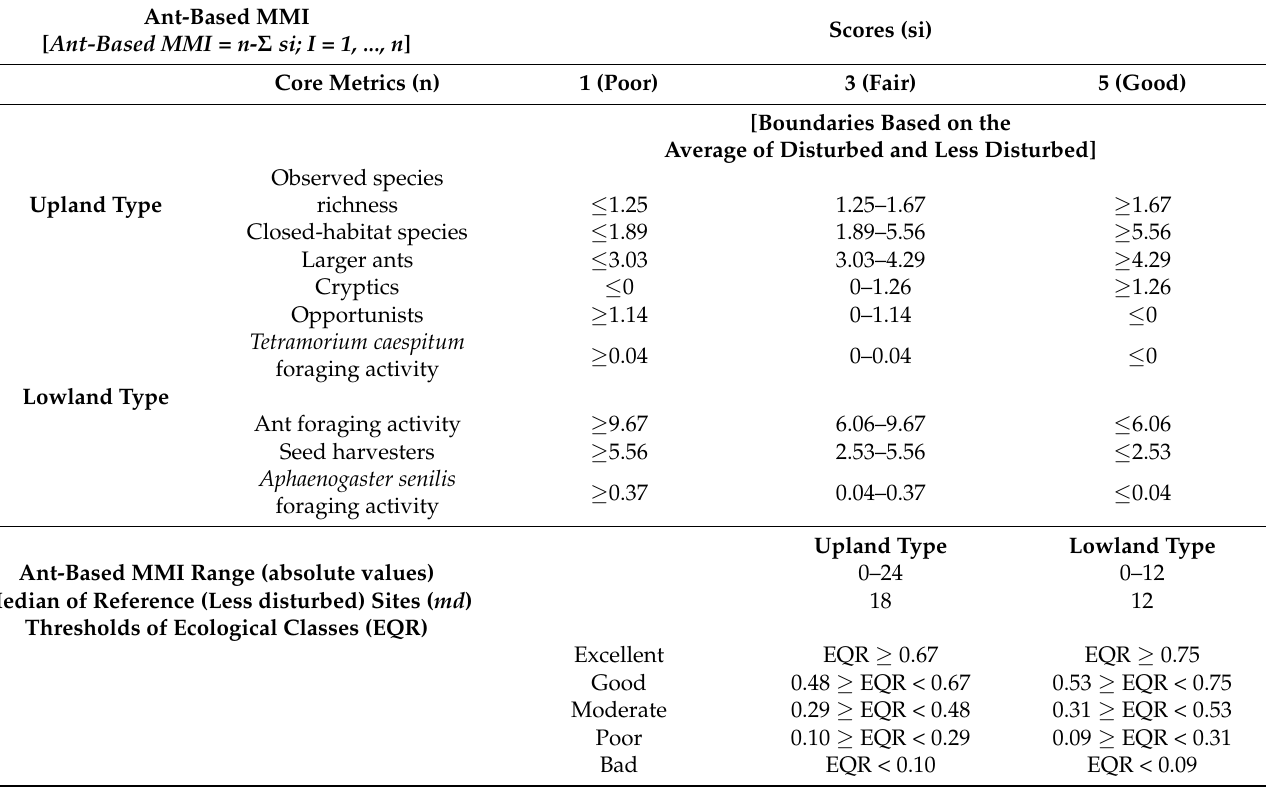
Table 3. Designation and calculation of the Ant-based MMI, units and scoring criteria used to rescale the metric values. Ant-based MMI range (minimum and maximum sum of scores) and median of reference (md) sites. Ecological